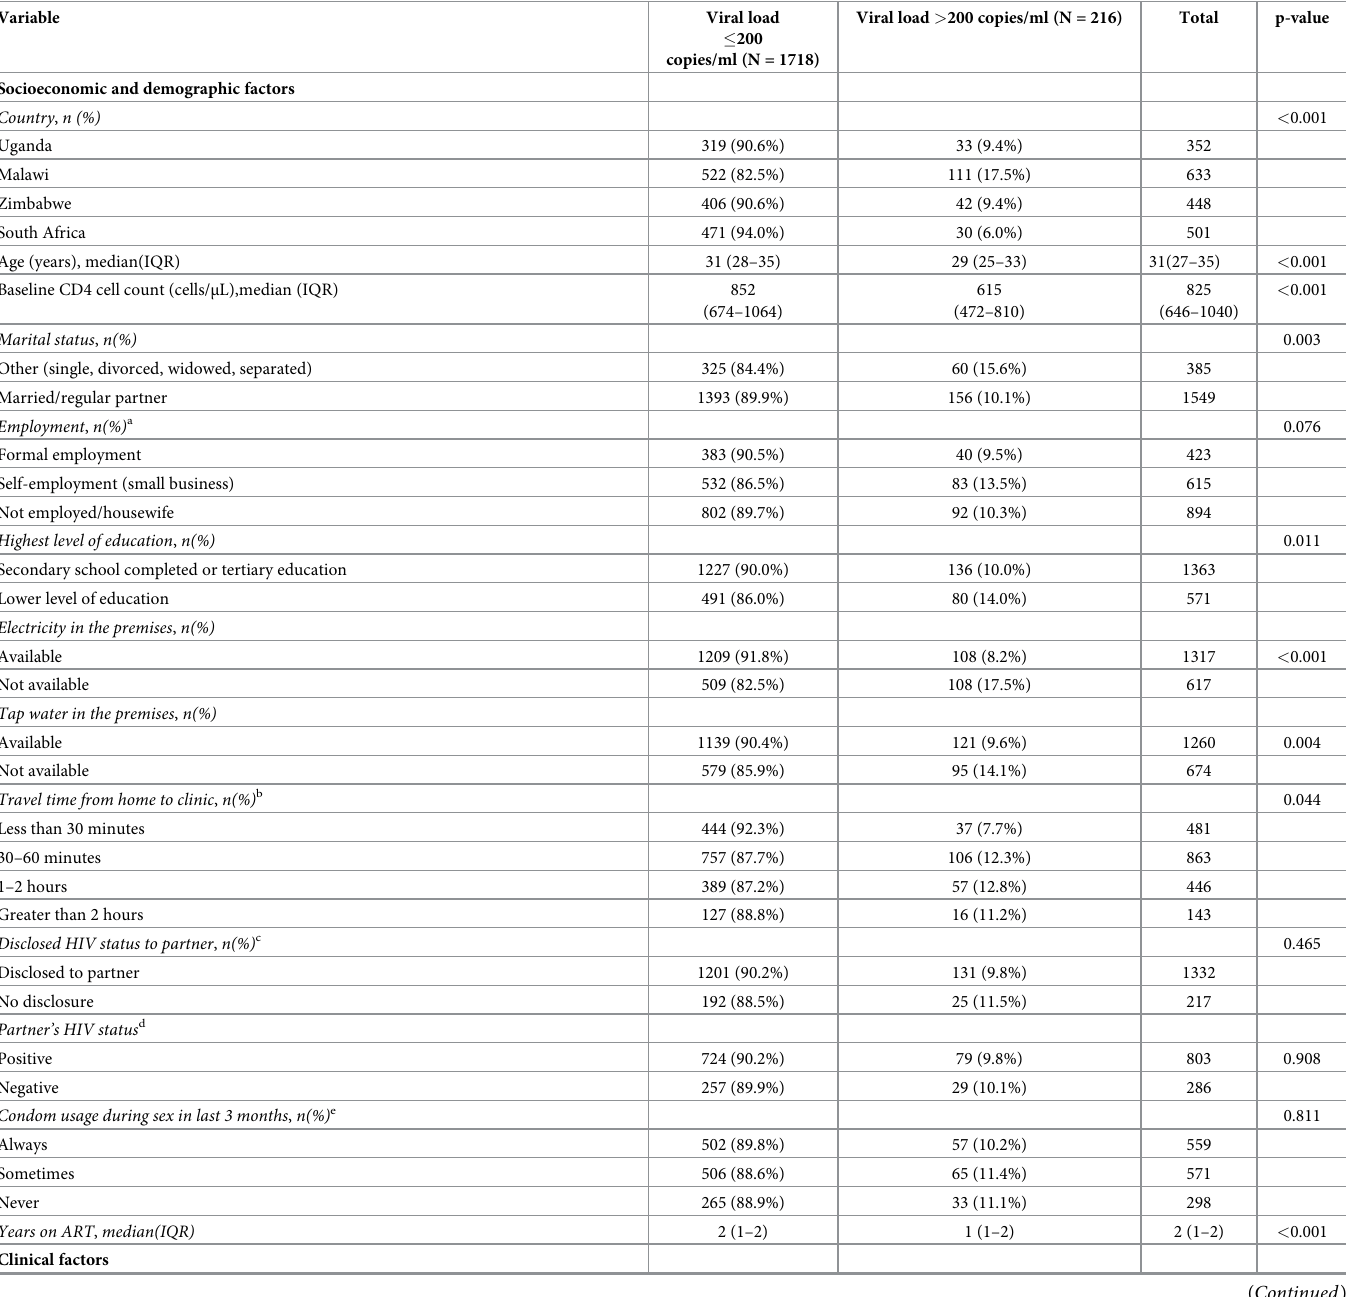
Table 1. Individual and contextual baseline